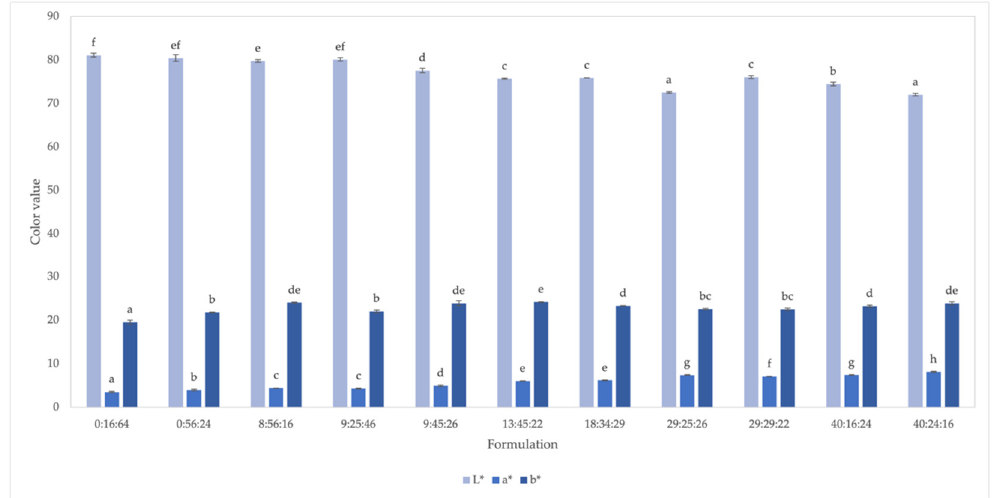
Figure 3. Color of extruded snacks with different proportions of flours (%okara, %mung bean, %rice). a–f Means with different letters within the same response are different ( p < 0.05; n = 3). Increasing okara powder in the formulation resulted in darker and redder snacks (Figure 4). The lowest L* value (72.51) and highest a* value (7.4) was observed in formula- tion 29:25:26 (Figure 3). According to [37], the color of extrudates made from agricultural by-products progressively intensifies as the quantity of by-product increases. Color changes could occur due to pigment degradation in the by-products, the Maillard reaction, and oxidation during extrusion [38]. The influence of processing temperature on the color of soy-based snacks with 13% okara was reported: The fried product was darker than the baked product (L = 50.98 vs. 53.90, p < 0.05; [39]).